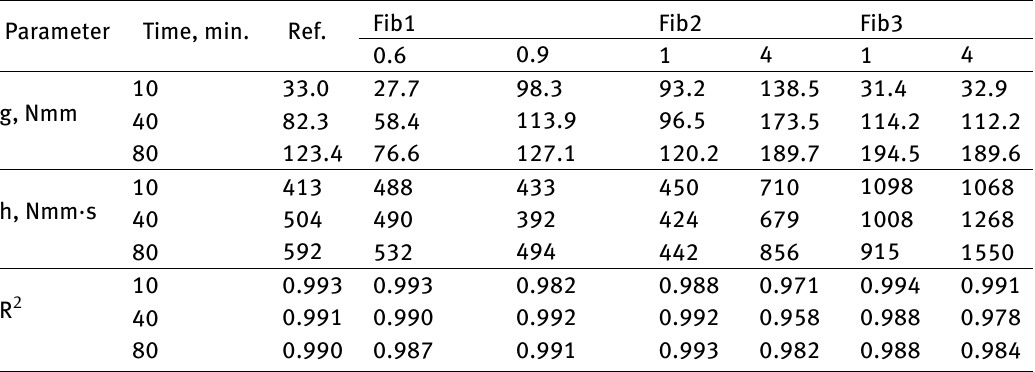
Table 3: Rheological test results.